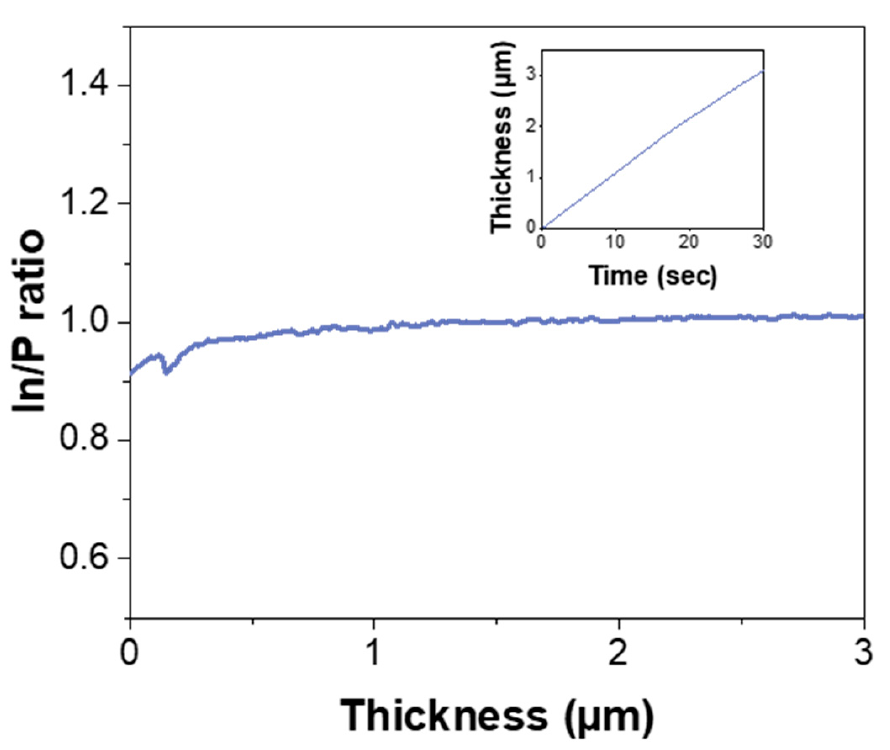
Figure 1. Pulsed RF GD-OES (pulsed Radio Frequency Glow Discharge Optical Emission Spectrometry) depth profile on the InP substrate. The insert corresponds to the DiP (Differential interferometry Profiling) measurement of the thickness sputtered over the plasma exposure time.